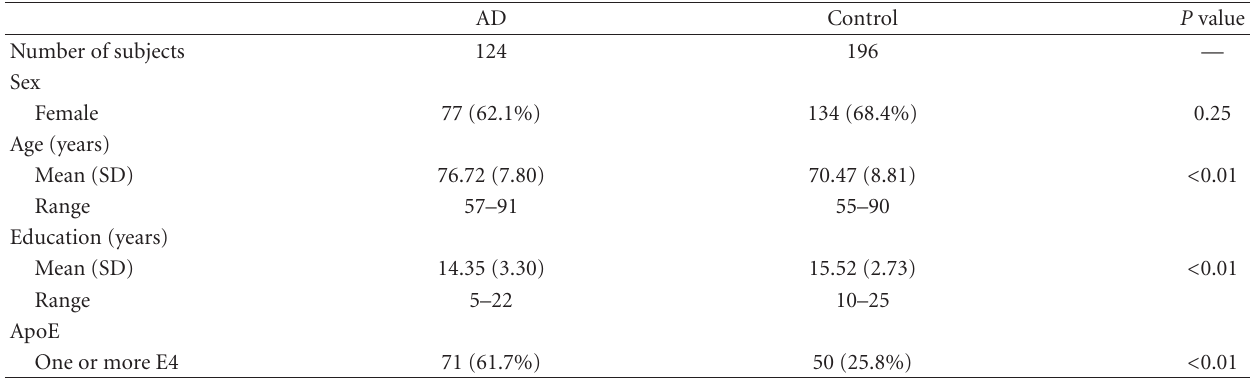
Table 2: Demographics by